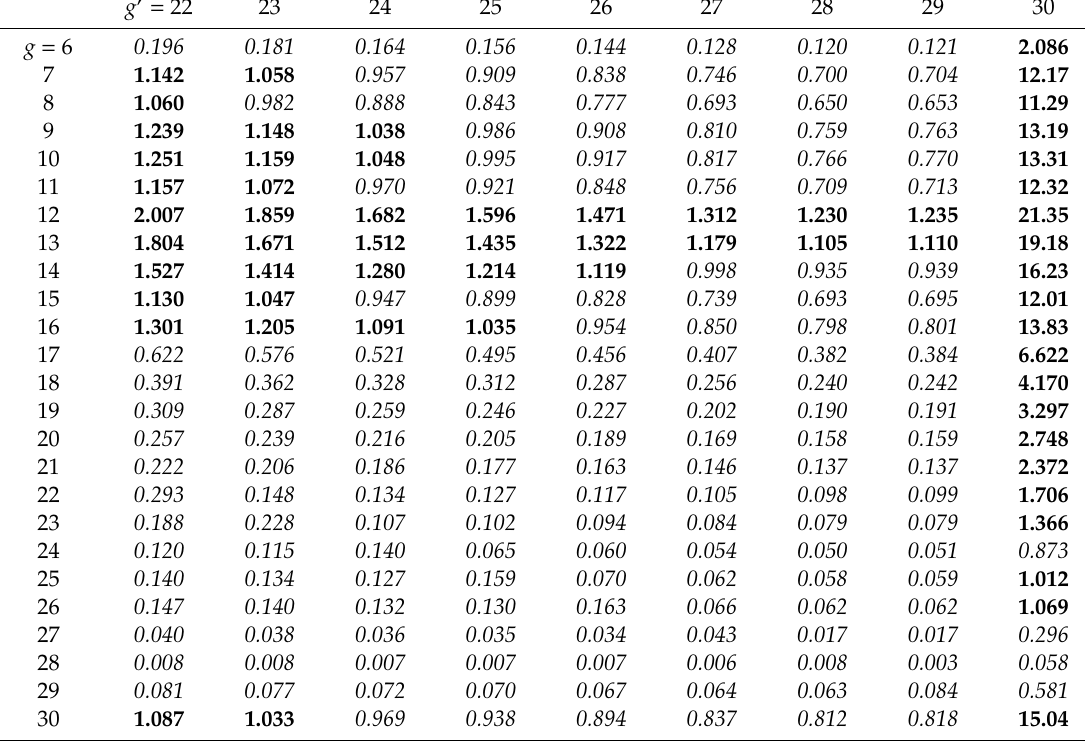
Table 14. Continuation of Table